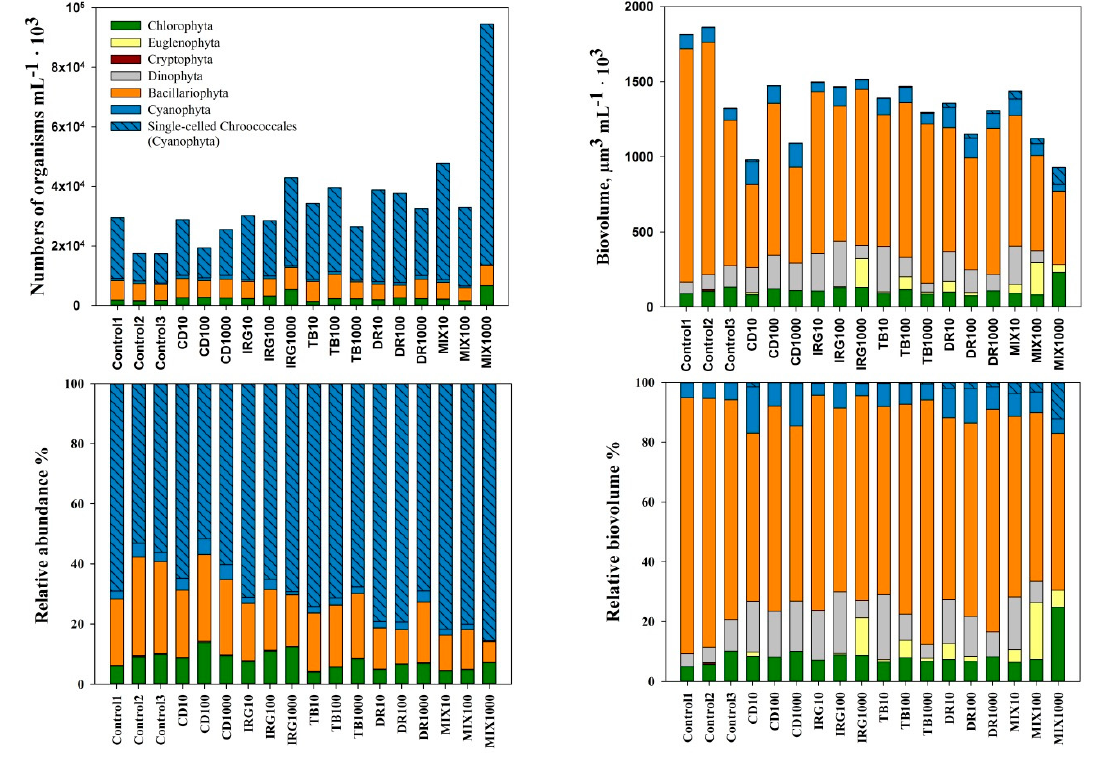
Figure 1. Phytoplankton taxa distribution in the water phase microcosm study. Absolute and relative values are given with respect to the counted numbers of organisms and the estimated biovolumes.